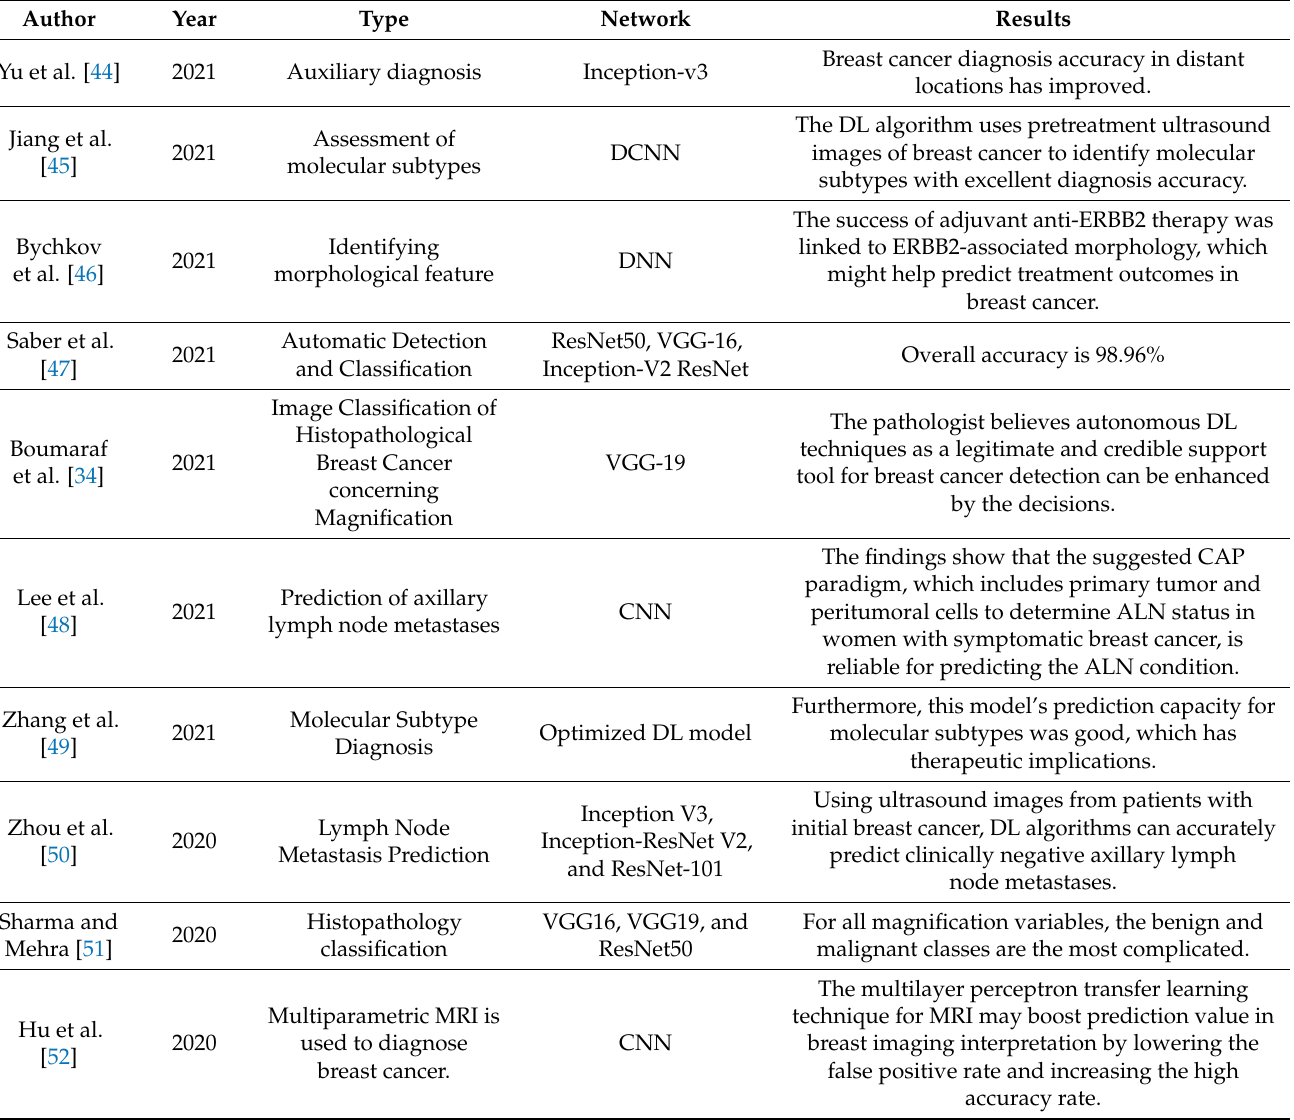
Table 1. Summary of research for diagnosis of breast cancer based on DL